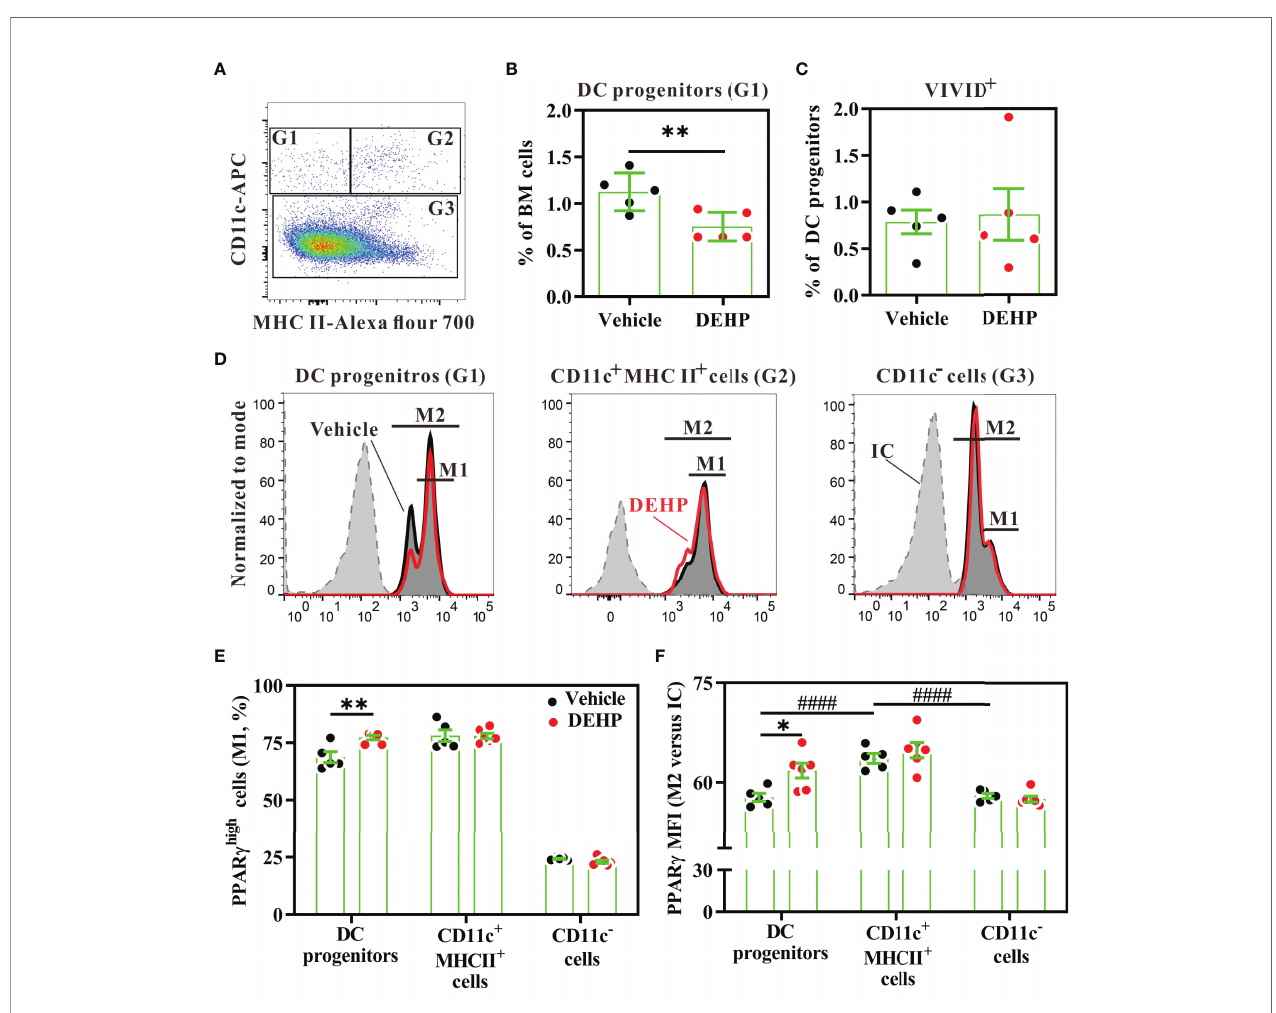
FIGURE 4 | Analysis of PPAR g expression in bone marrow DC progenitors. BALB/c mice were given oral DEHP, at a dosage of 37 m g/kg BW/day, or 0.33% ethanol in corn oil as vehicle, for 10 d. Bone marrow cells from treated mice were analyzed for DC progenitors using multi-parametric fl ow cytometry. (A) Representative dot plots of DC progenitors (G1, CD11c + MHC class II - ), differentiating DCs (G2, CD11c + MHC class II + ), and CD11c - cells (G3) gated from viable Lin - bone marrow cells. (B) The percentage of DC progenitors in viable Lin - bone marrow cells. (C) The percentage of dead cells (ViViD + ) in DC progenitors (G1). (D) Representative histograms showing intracellular PPAR g expression in each cell subset. (E) The frequency of PPAR g high cells (M1) in the gated cells, as shown in (D) . (F) The fold change of mean fl uorescence intensity (MFI) of PPAR g (M2) versus isotype control (IC) in the gated cells, as shown in (D) n = 5 or 6 mice for each group. Results are shown as mean ± SEM. *P < 0.05 and **P < 0.01, as assessed using Mann – Whitney U test. #### P < 0.0001, as assessed using one-way ANOVA followed by Dunnett ’ s multiple comparison